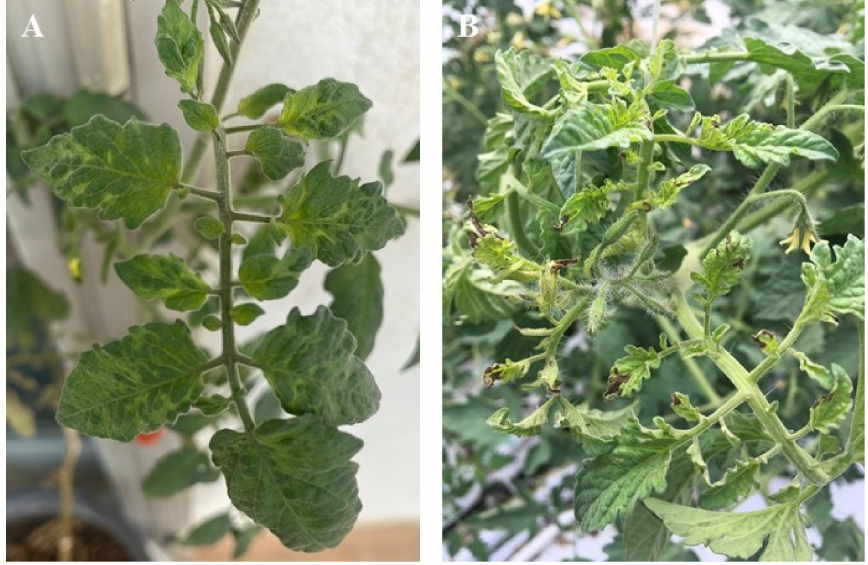
Figure 13. Leaf deformations with mosaic and blistering ( A ) or yellowing and necrosis ( B ) caused by Tomato brown rugose fruit